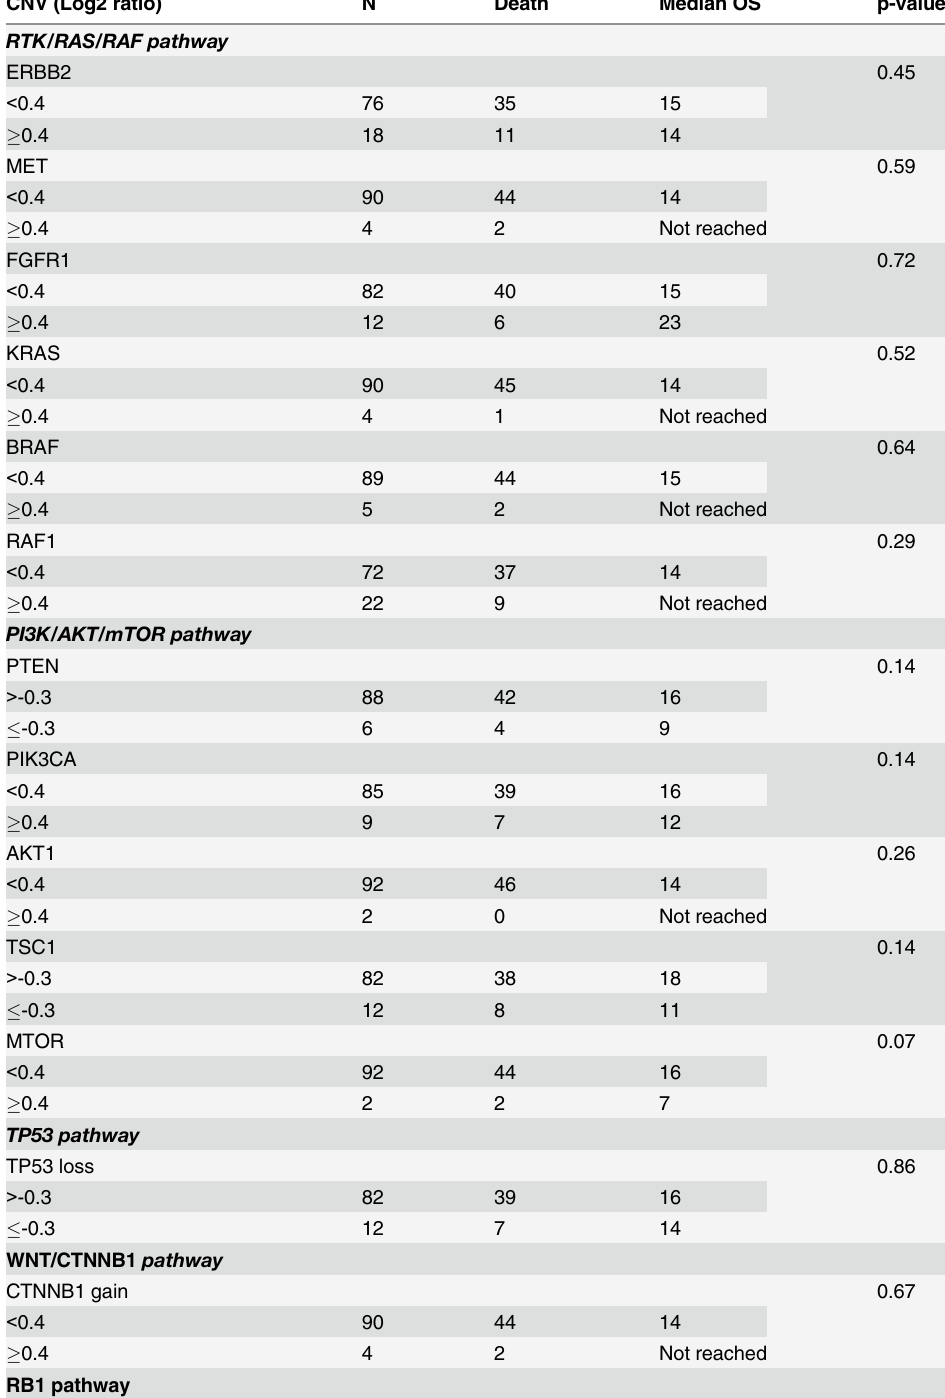
Table 4. Association of CNV of genes In TP53, RTK/RAS/RAF, PI3KCA/AKT/mTOR, WNT/CTNNB1 and RB1 pathways with